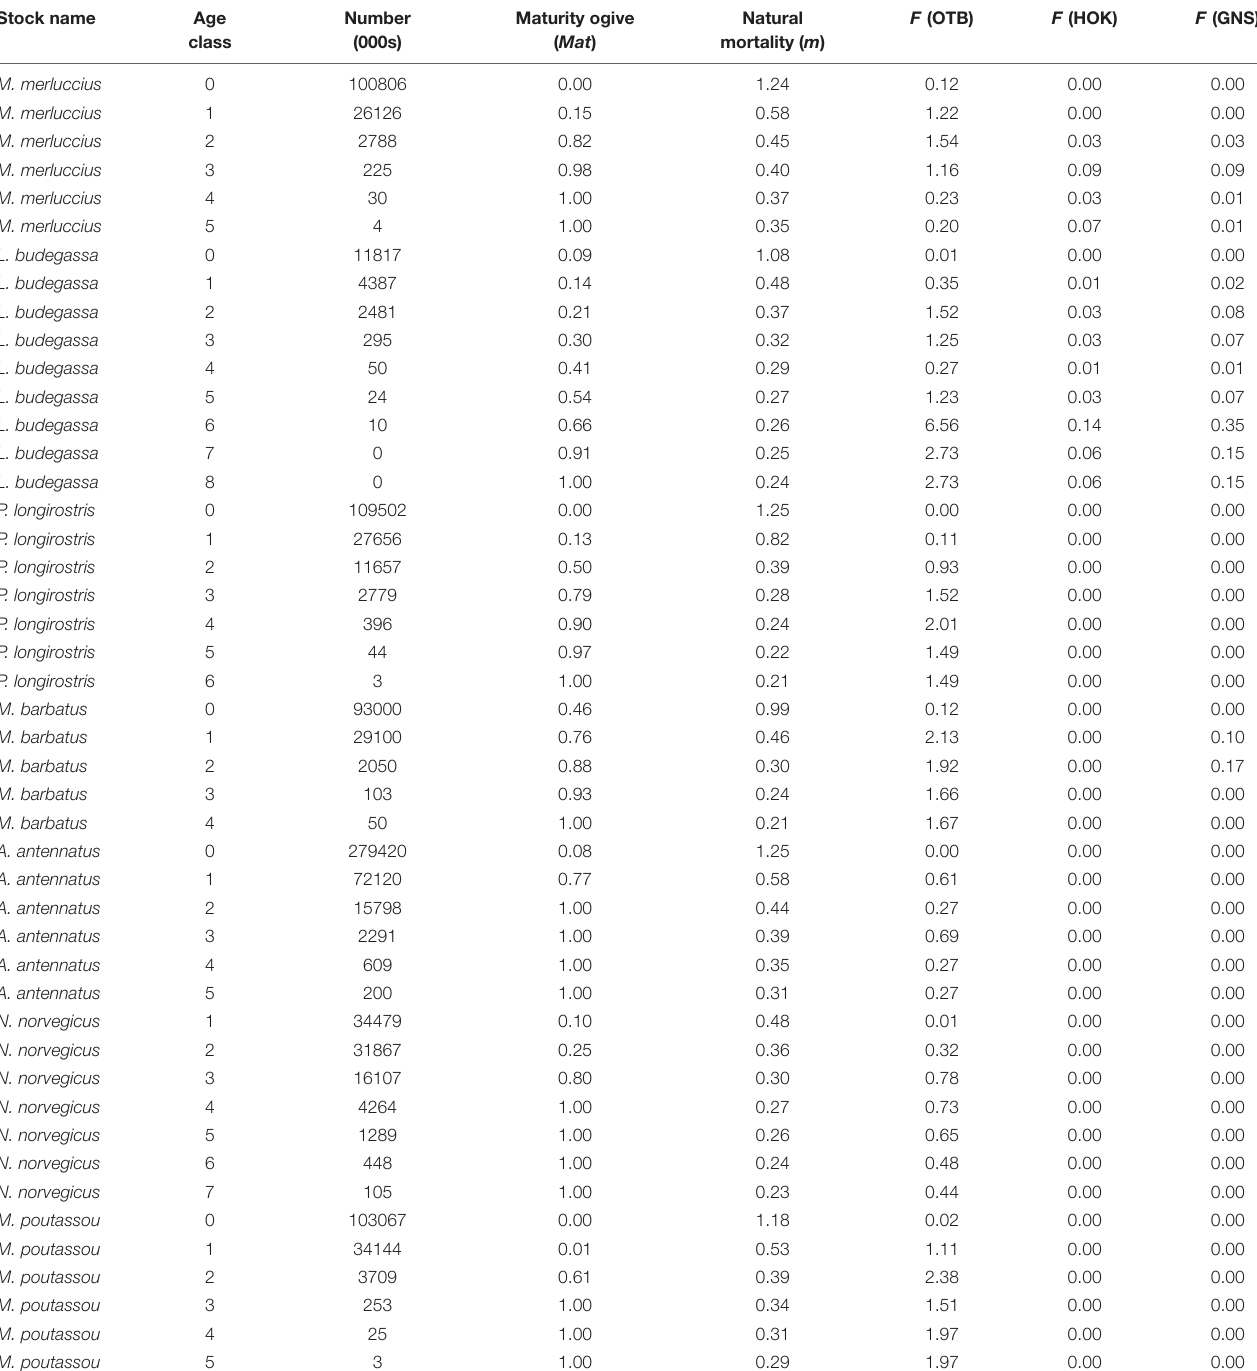
TABLE 3 | Biological parameters used in the bioeconomic model of GSA 06. F is the fishing mortality distributed among fishing fleets. Stock